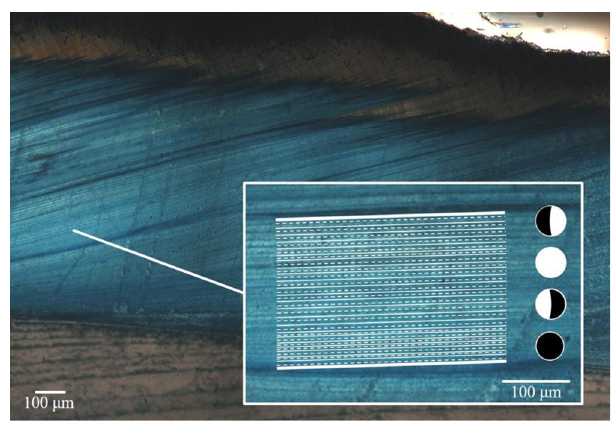
Fig. 5 Sclerochronological features of limpet mollusc shell. An image of a stained thin-section under light microscopy detailing growth features of C. sandwicensis shell that experience mixed tides in a wave-dominated rocky